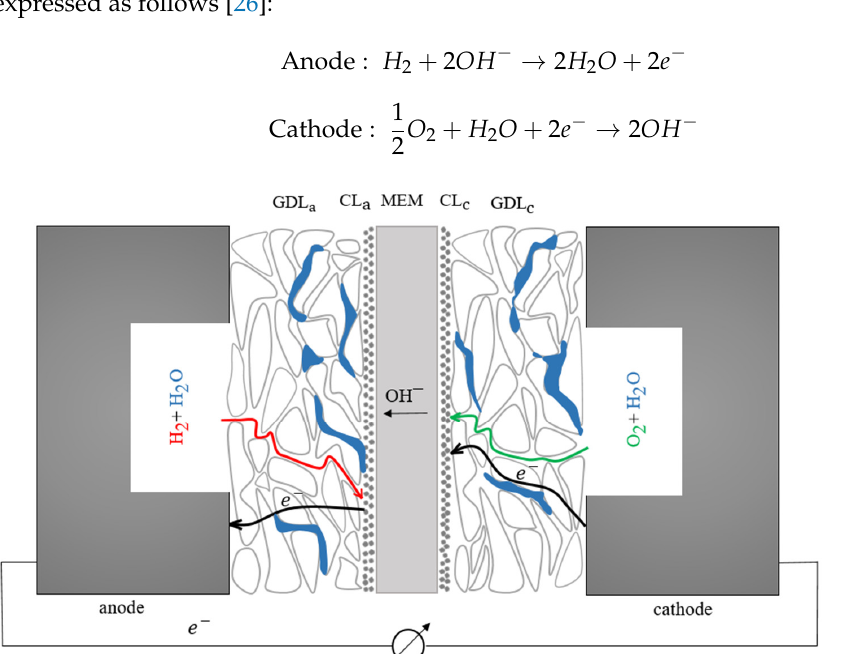
Figure 2. Schematic representation of the AEMFC working principles. The humidified reactants are fed through the channels, passed through the gas diffusion layers, and dissociated at the catalyst layers. The generated hydroxyl ions move through the membrane while the electrons pass through the external circuit and load, reaching the cathode where they recombine with oxygen and water. The blue patches represent water, whereas the red line is hydrogen and the green line is oxygen.